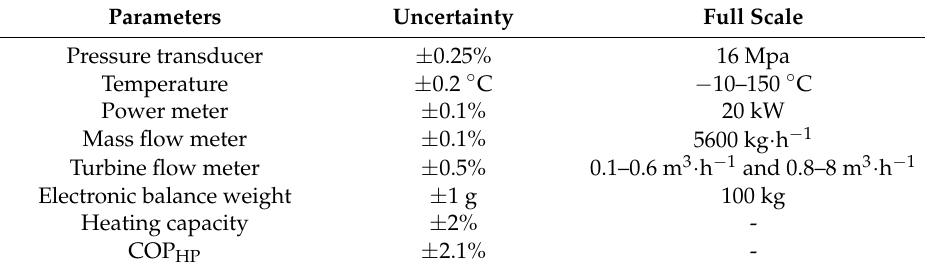
Table 2. Uncertainties of experimental